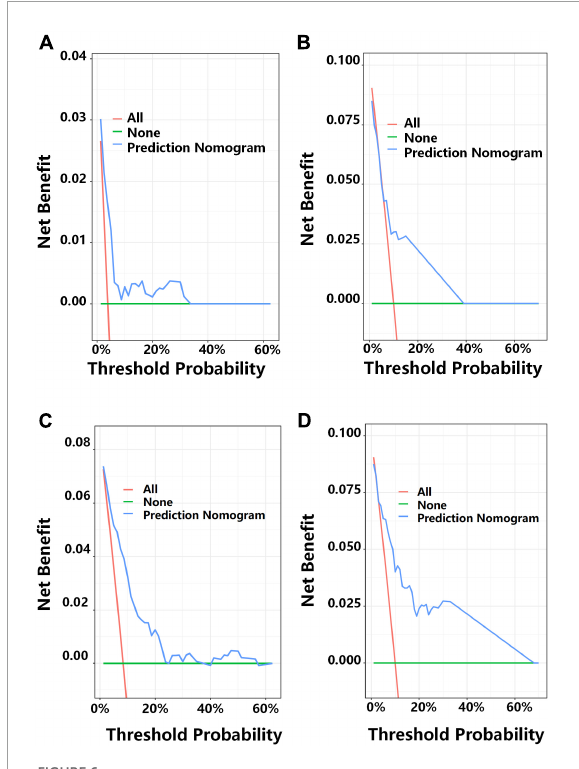
FIGURE6 Decision curve analysis (DCA) for predicting 1-year MACE-free survival in the development cohort (A) and the external validation cohort (B) , and 2-year MACE-free survival in the development cohort (C) and the external validation cohort (D) . Each plot shows the relationship of threshold probability (abscissa) with the net benefit (ordinate) of the prediction model (blue line), the proportion of patients with MACEs (red line), and the proportion of patients with MACE-free survival (green